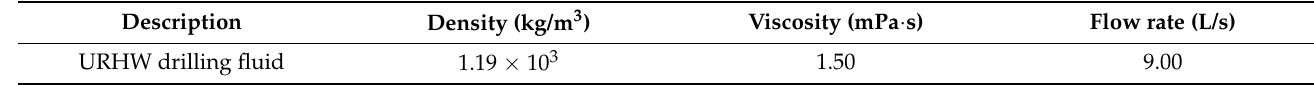
Table 2. Properties of the drilling fluid set in CFD